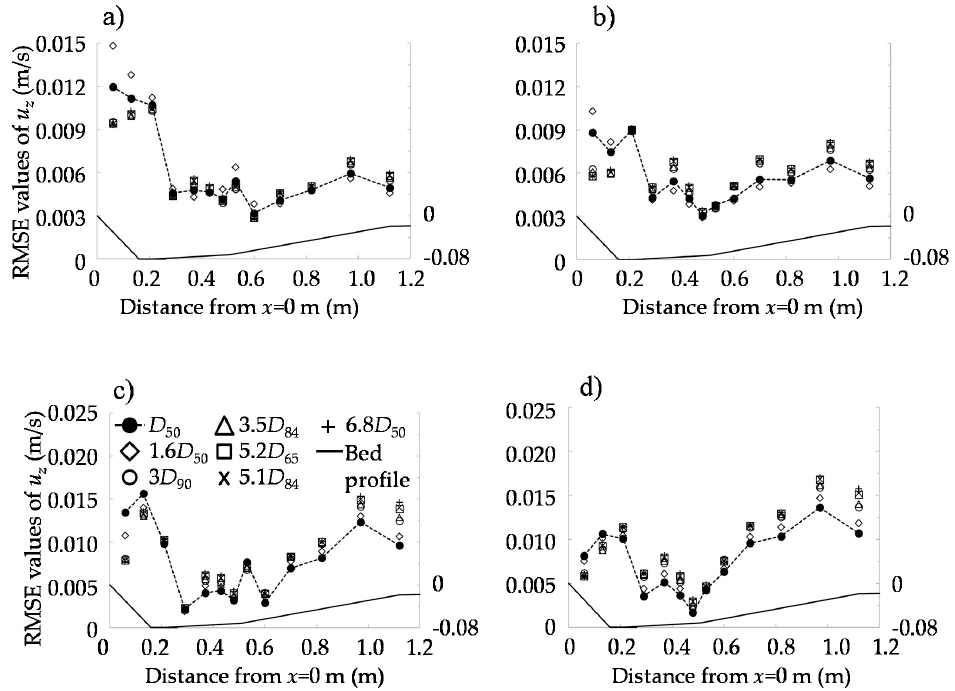
Figure 7. RMSE of flow velocity in depth-wise direction with various bottom roughness height formulas: ( a ) Fully depth-averaged (0 < z / h 0 < 1) RMSE with k- ε model; ( b ) Fully depth-averaged with k- ω SST model; ( c ) Partially depth-averaged (0 < z / h 0 < 0.15) k- ε model for the lower part; ( d ) Partially depth-averaged (0 < z / h 0 < 0.15) k- ω SST